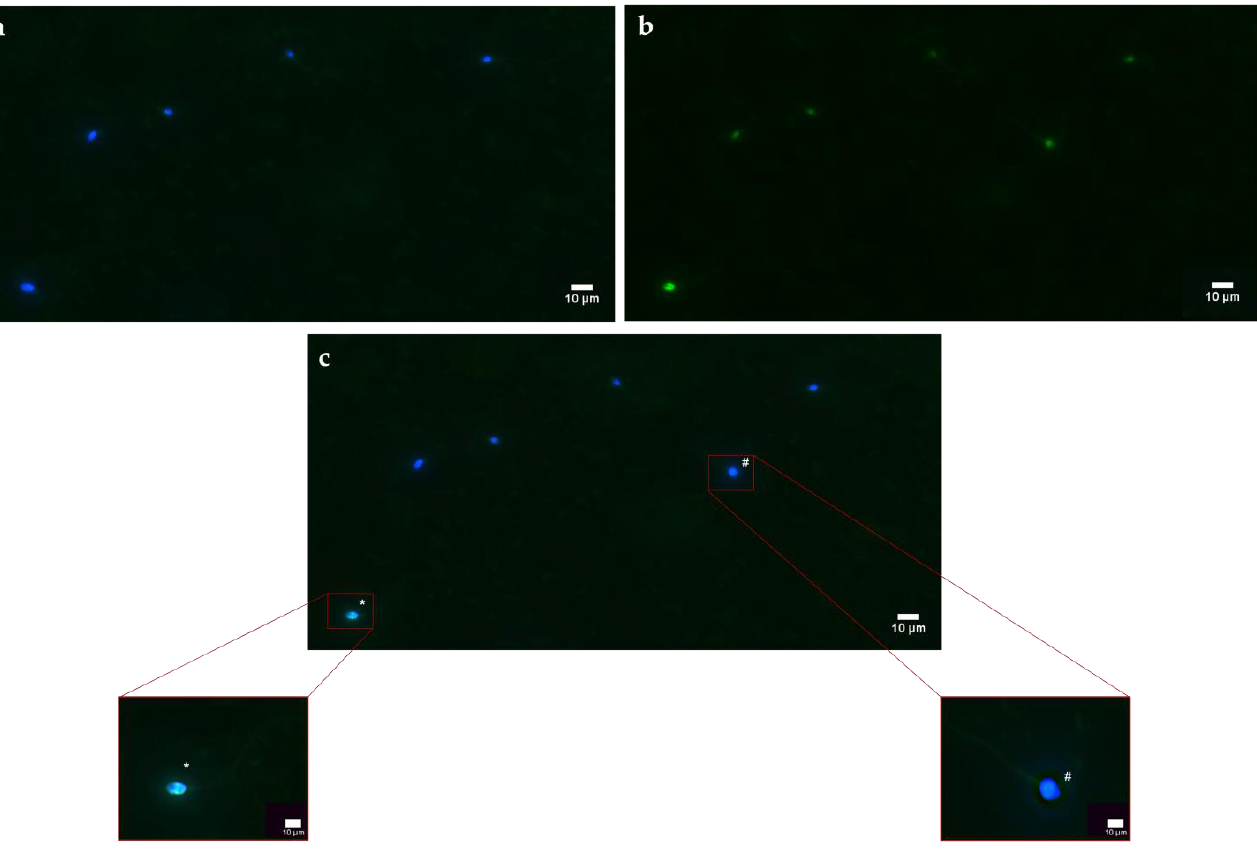
Figure 6. Observation of a casual field of spermatozoa subjected to DCFH2-DA test to assess ROS production: ( a ) observation of spermatozoa under epifluorescence microscope with 40× magnification, using DAPI channel acquisition; ( b ) observation of spermatozoa under epifluorescence microscope with 40× magnification, using FITC channel acquisition; ( c ) observation of spermatozoa under epifluorescence microscope with 40× magnification, using multichannel acquisition. The symbol * indicates a spermatozoon DCF+/Hoechst+, while # indicate a spermatozoon DCF−/Hoechst+.